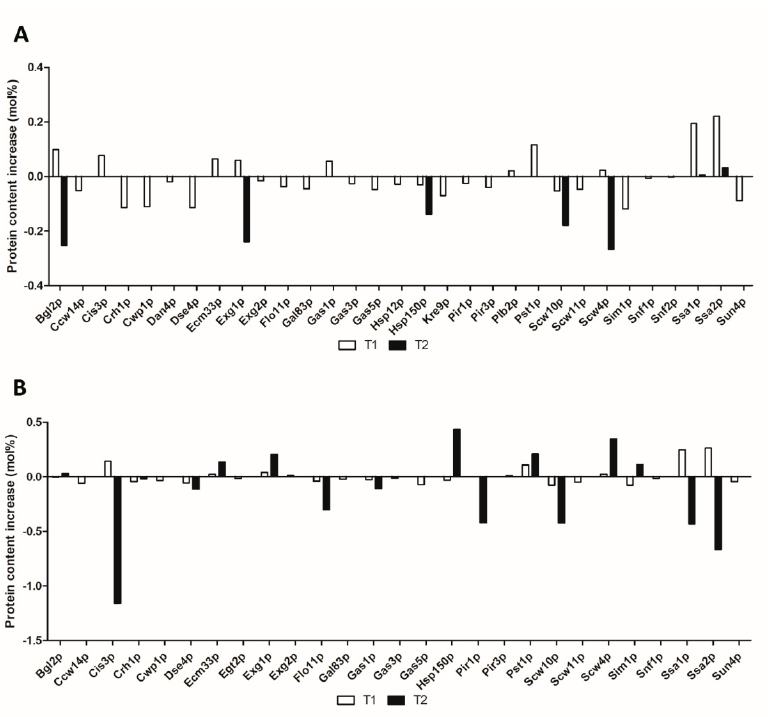
Figure 2. Protein content increases (mol%) observed in ( A ) S. cerevisiae P29 and ( B ) S. cerevisiae G1, under pressure conditions (PC) compared to non-pressure condition (NPC). T1 (middle of the second fermentation), T2 (one month after